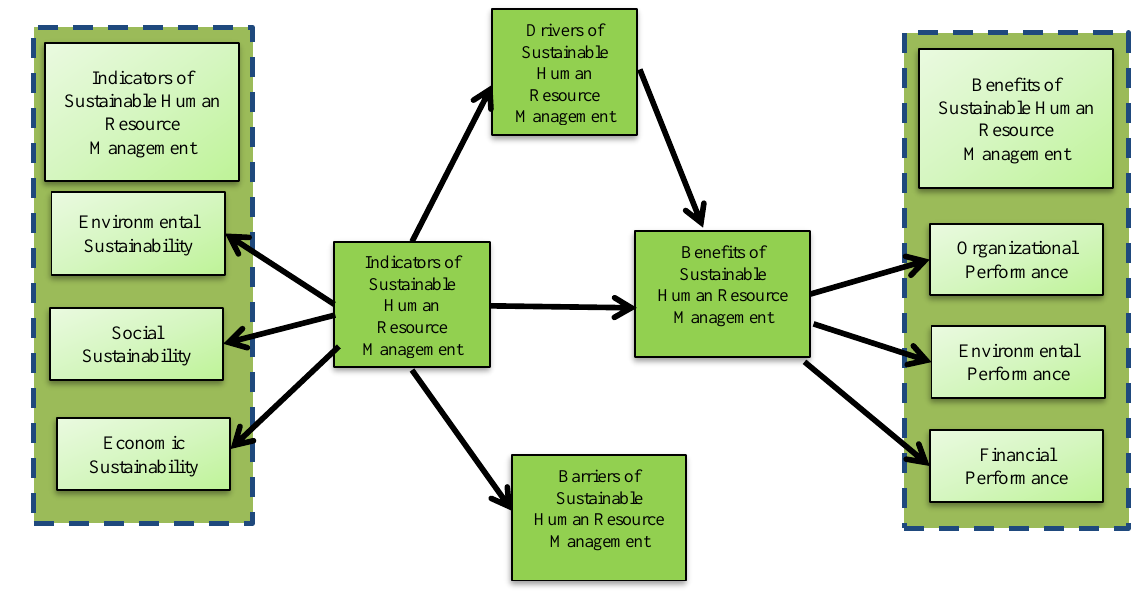
Figure 1. Proposal of SHRM framework for sustainability